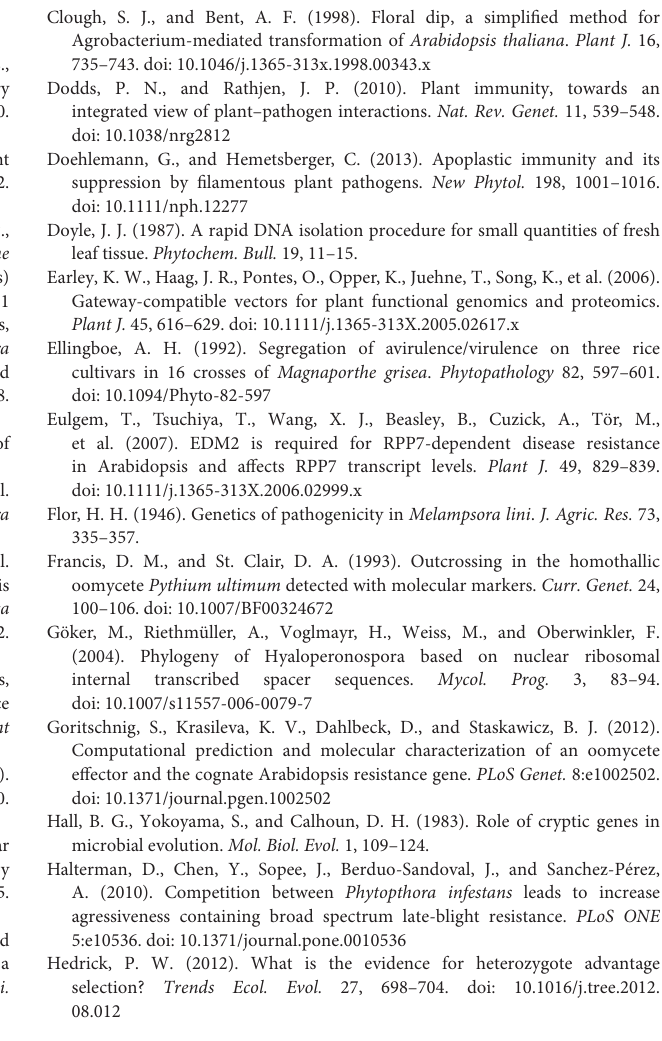
Supplementary Table 6 | Comparison of interaction phenotypes obtained from two independent published studies of Hyaloperonospora arabidopsidis isolates Hpa -Emwa1 and Hpa -Emco5 on 83 Arabidopsis accessions of the Nordborg/Bergelson